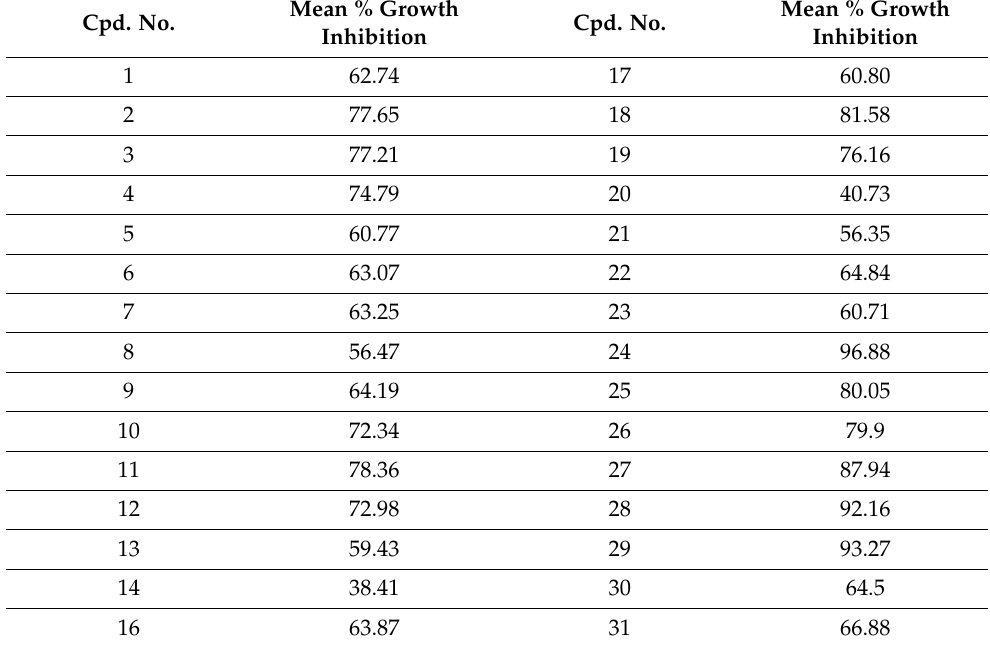
Table 2. NCI mean % growth inhibition values. Cpd.